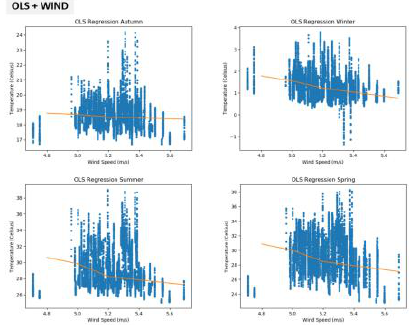
Figure 22: OLS Regression Model LST in 4 seasons (Temperature – Land Cover - Wind)